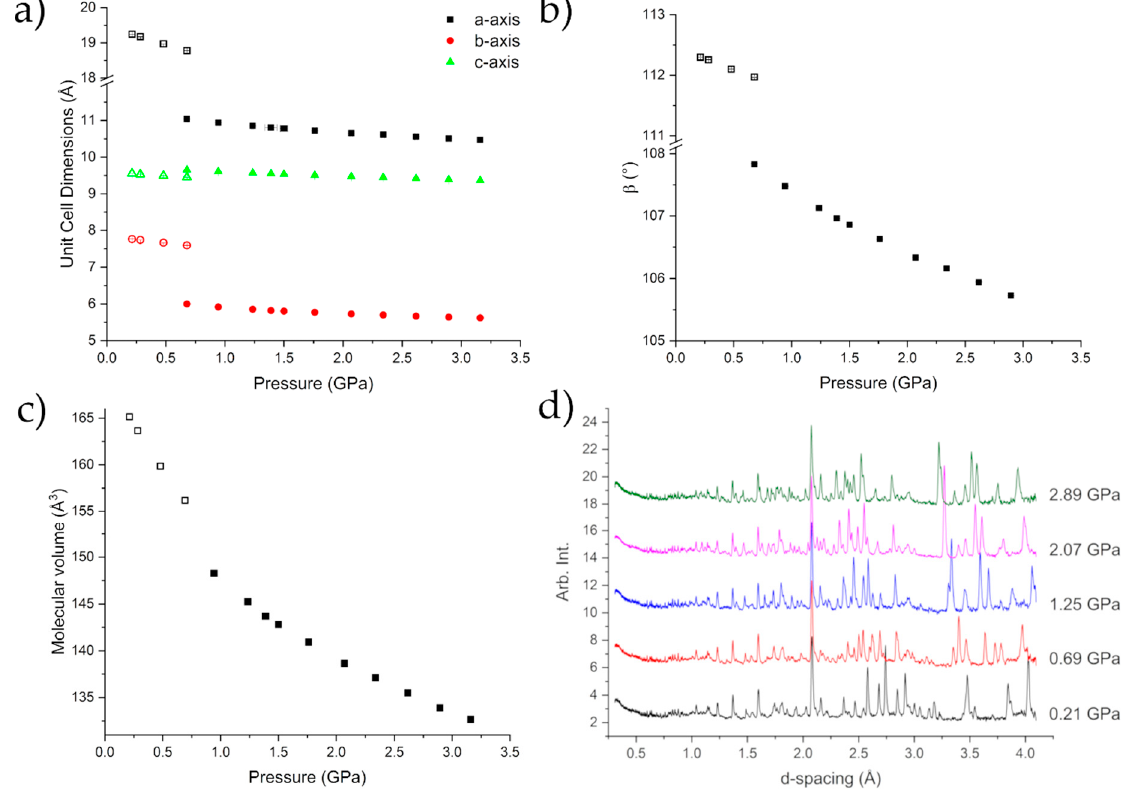
Figure 4. Compression of the unit cell dimensions ( a & b ) indicating the phase transition to Form II caprolactam- d 10 . There is a discontinuity in the molecular volume over the transition ( c ). The diffraction patterns of caprolactam as a function of pressure indicating the mixed phase 0.692(14) GPa ( d ). The error bars are smaller than the symbols.